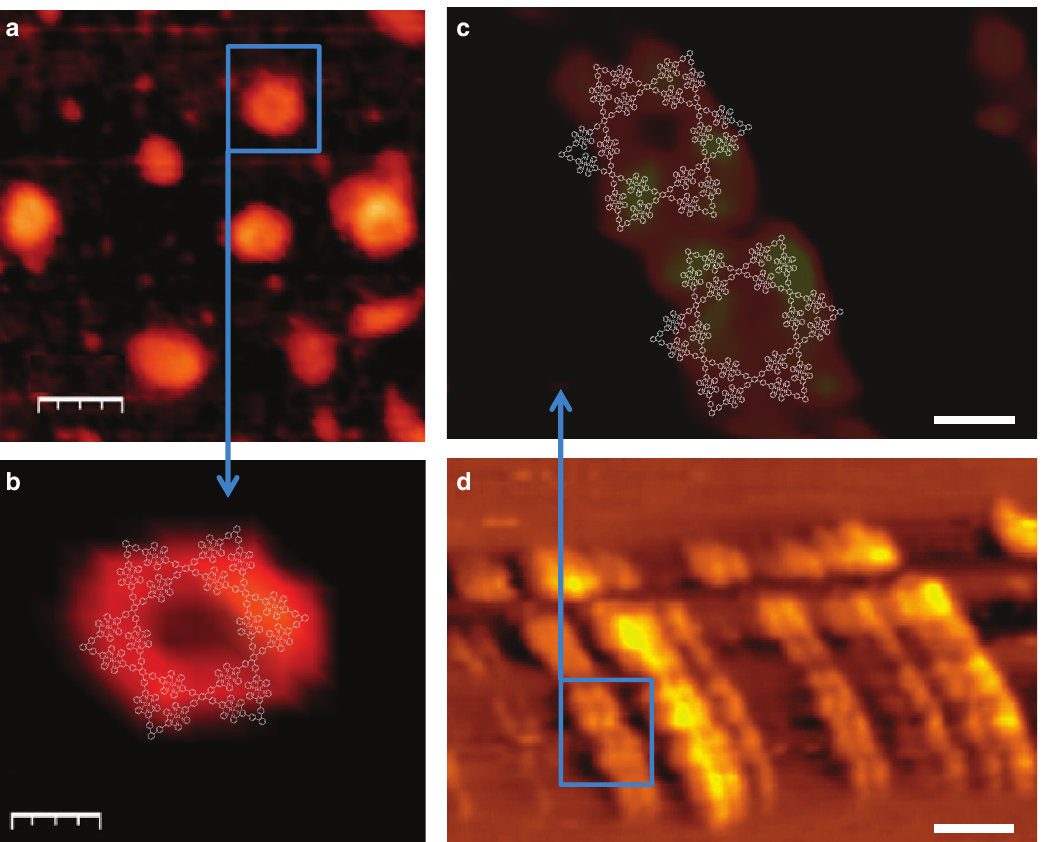
Figure 7 | AFM and STM images of metallo-hexagram. ( a , b ) AFM images on mica (scale bar, 40 and 9.3nm, respectively). ( c , d ) STM images on HOPG at ambient condition (scale bar, 5 and 25nm,